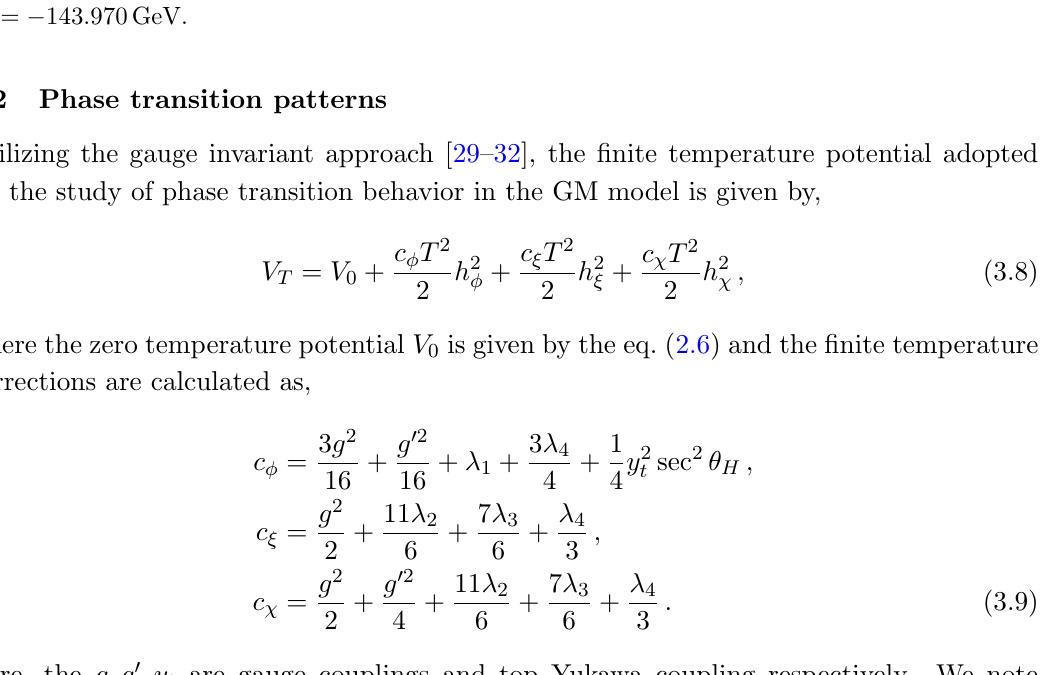
Figure 2 . The contours of V 0 (in units of GeV 4 ) in h (cid:30) - h (cid:24) (in units of GeV) plane. With the left plot parameters being: (cid:21) 1 = 0 : 043, (cid:21) 2 = 0 : 933, (cid:21) 3 = (cid:0) 0 : 863, (cid:21) 4 = 0 : 321, (cid:21) 5 = 1 : 267, (cid:18) H = 0 : 241, v = 246 GeV, (cid:22) 1 = (cid:0) 289 : 785 GeV, (cid:22) 2 = (cid:0) 2 : 928 GeV. With the right plot parameters being (cid:21) 1 = 0 : 0322, (cid:21) 2 = 1 : 069, (cid:21) 3 = (cid:0) 1 : 025, (cid:21) 4 = 0 : 706, (cid:21) 5 = (cid:0) 0 : 311, (cid:18) H = 0 : 026, (cid:22) 1 = (cid:0) 11 : 128